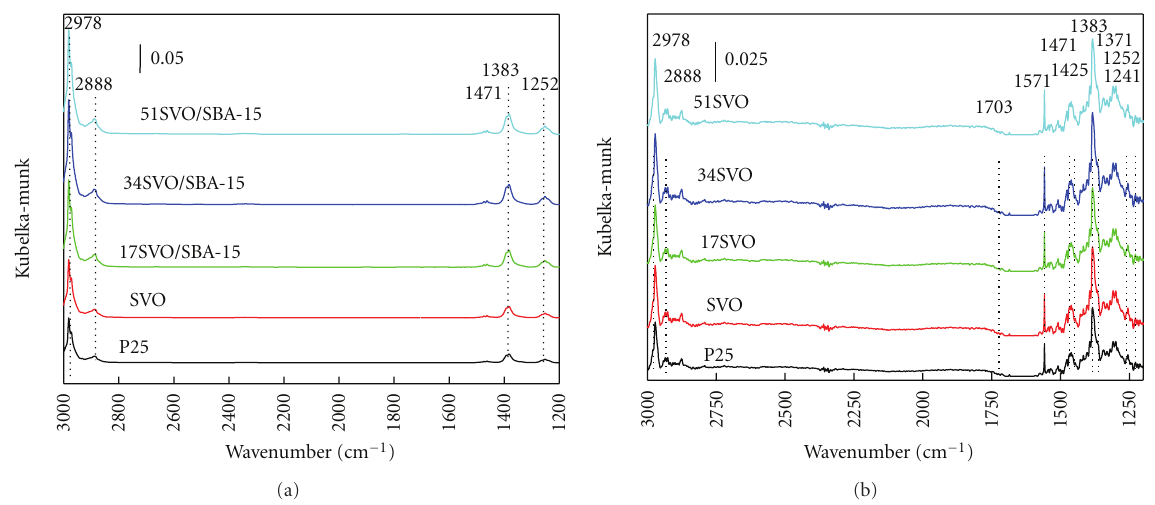
Figure 4: DRIFTS spectra of samples (a) after adsorption of IPA for 30 min and (b) after visible-light illumination for 60min.